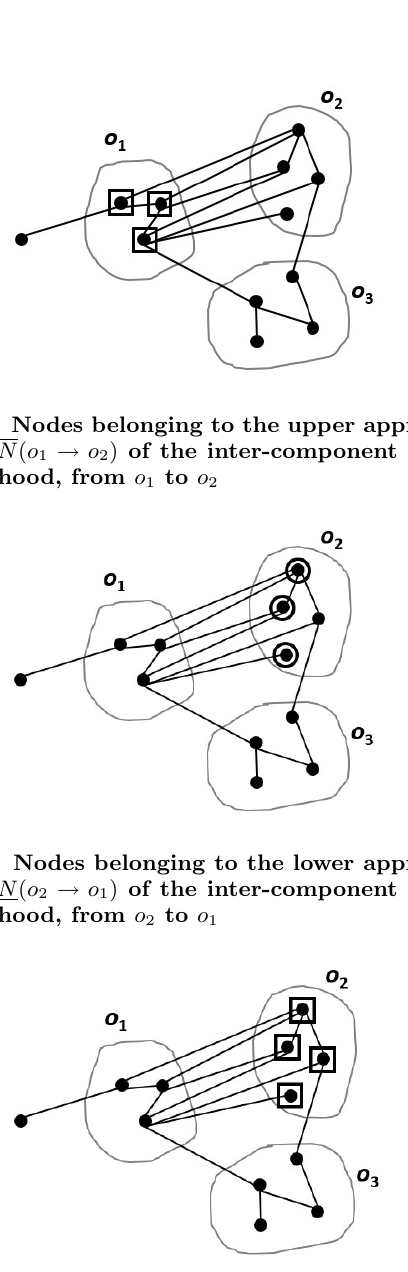
Figure 7: Nodes belonging to the upper approxima- tion ICSN ( o 2 → o 1 ) of the inter-component saccade neighborhood, from o 2 to o 1